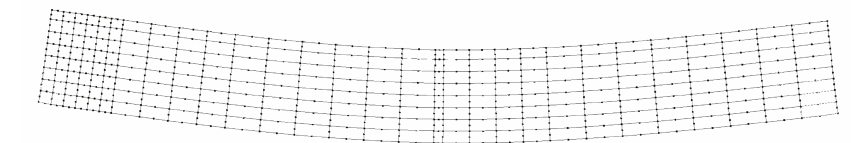
Figure 14. Lateral view of the deformed bar.